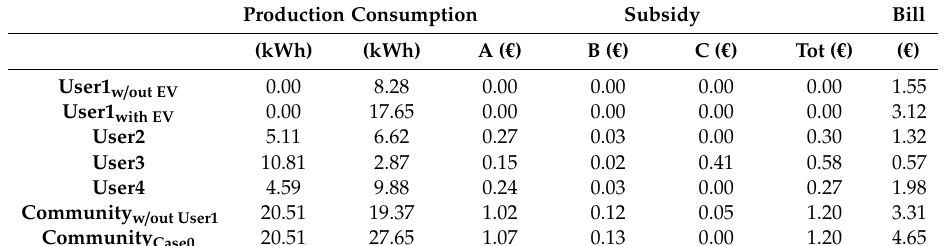
Table 3. Subsidies and bills.